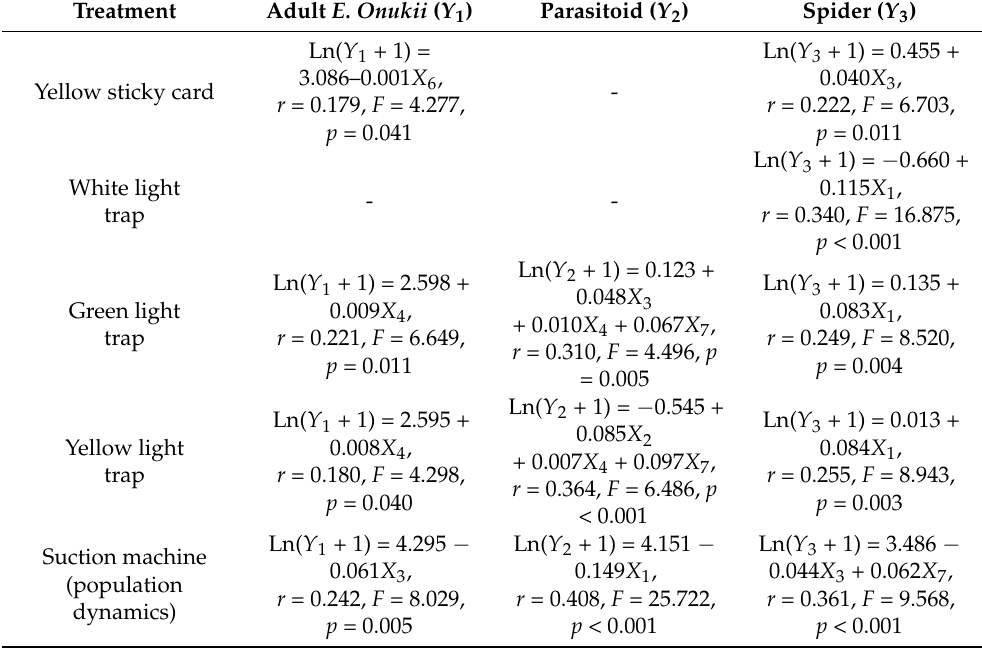
Table 2. Regression equations for the influence of weather variables on the population dynamics of leafhoppers, parasitoids and spiders under the four trapping techniques and the suction machine.